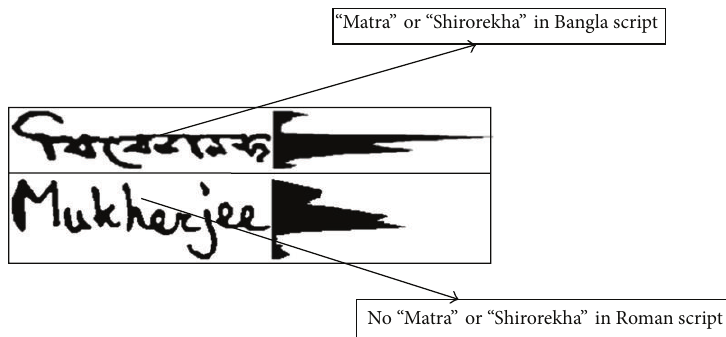
Figure 4: Presence of “Matra” or “Shirorekha” in Bangla script: the same is absent in Roman [18].